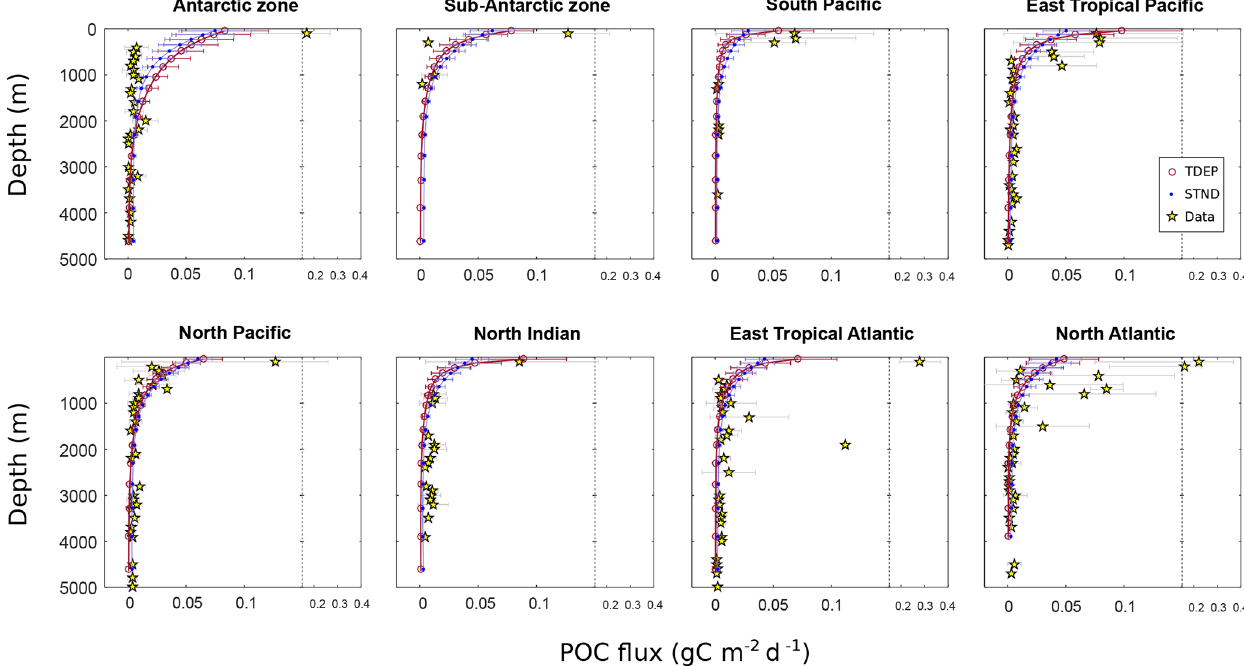
Figure 12. POC flux (gCm − 2 d − 1 ) for the model (mean and standard deviation) and data. Data from Mouw et al. (2016a). STND is the standard model, and TDEP is the temperature-dependent